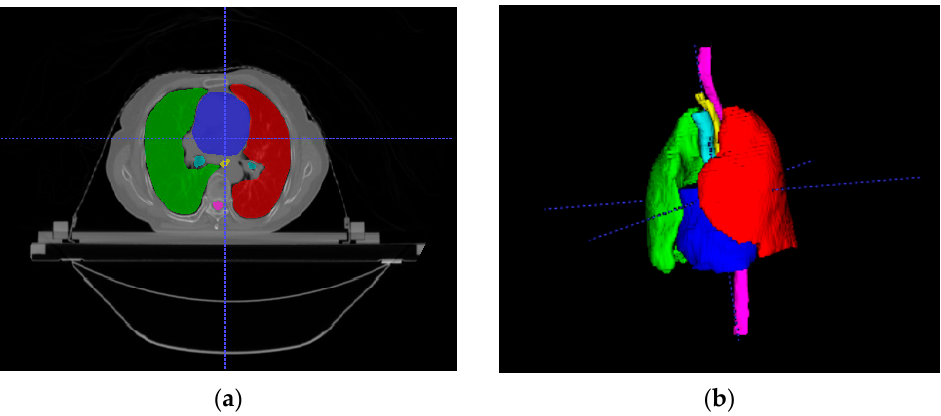
Figure 5. Example of OARs from StructSeg 2019 dataset. ( a ) 2D image; ( b ) 3D image. Each OAR is shown in a different color. The green region is the left lung; the red region is the right lung; the pink region is the spinal cord; the turquoise is the trachea; the blue region is the heart, and the yellow region is the esophagus.